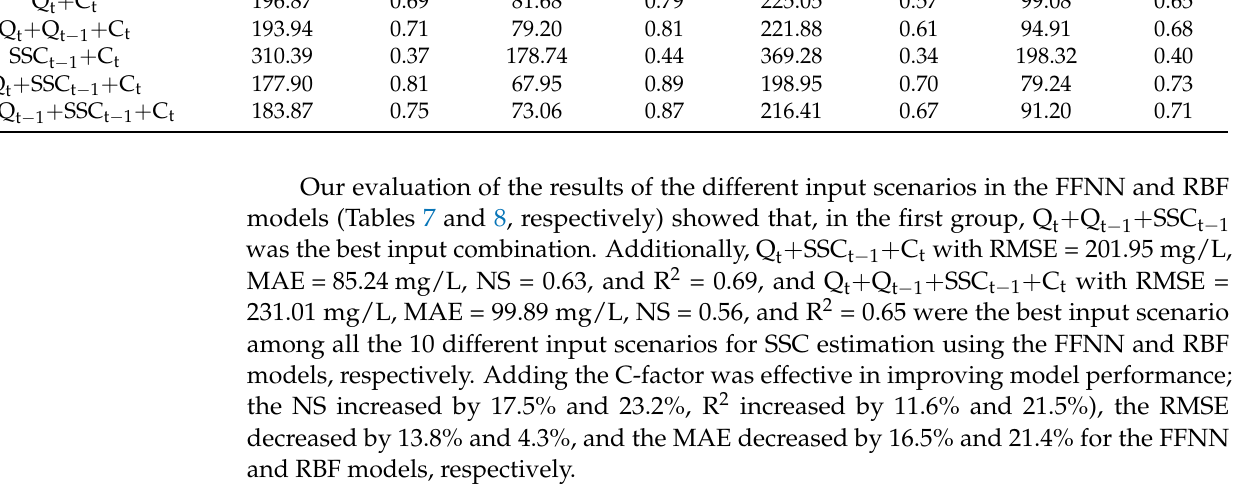
Table 7. Results of monthly SSC modeling by FFNN with different input patterns during training and test phases.